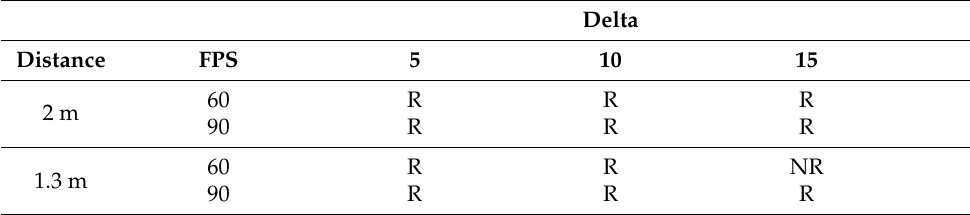
Table 4. Student’s t -test for lateral movement.